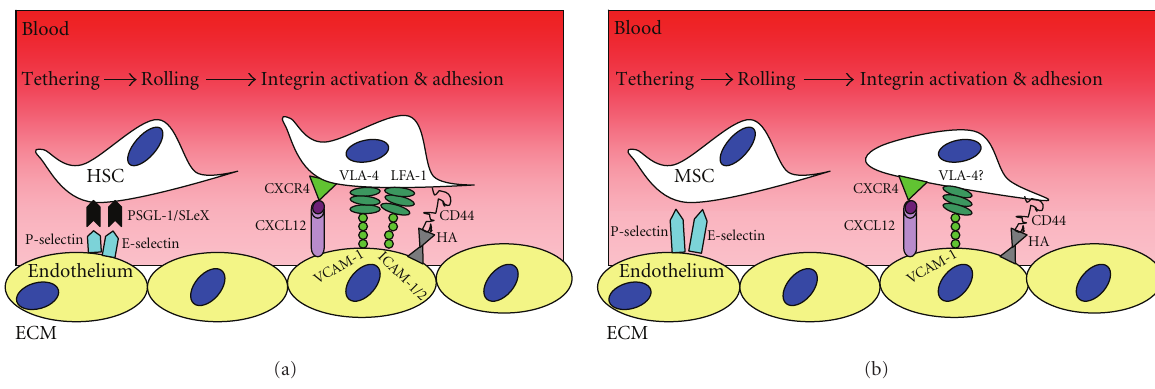
Figure 1: Schematic illustration of the molecular mechanisms used by (a) leukocytes for homing to the bone marrow and (b) di ff erences with